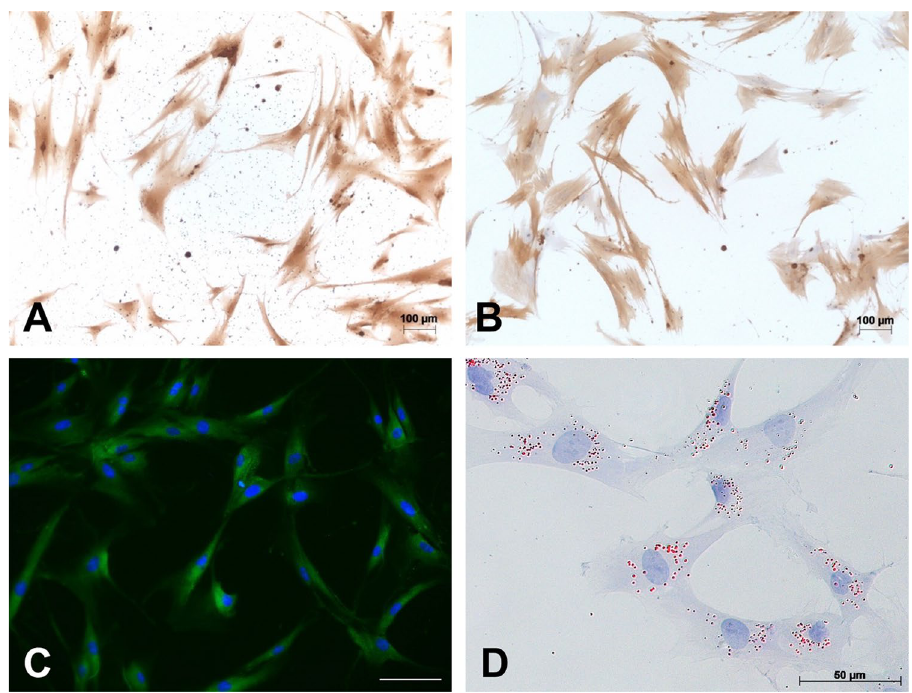
Figure 1. Immunocytochemistry (ICC) of PSCs with Periostin, α—Smooth Muscle Actin, Immunofluorescence (IF) of GFAP and Oil Red staining. Cells display strong cytoplasmatic staining with Periostin ( A ), α-SMA ( B ) and GFAP ( C ). Oil red staining of fresh isolated PSCs after 7 days of culture visualize cytoplasmatic vitamin A-containing lipid droplets ( D ). Magnification: